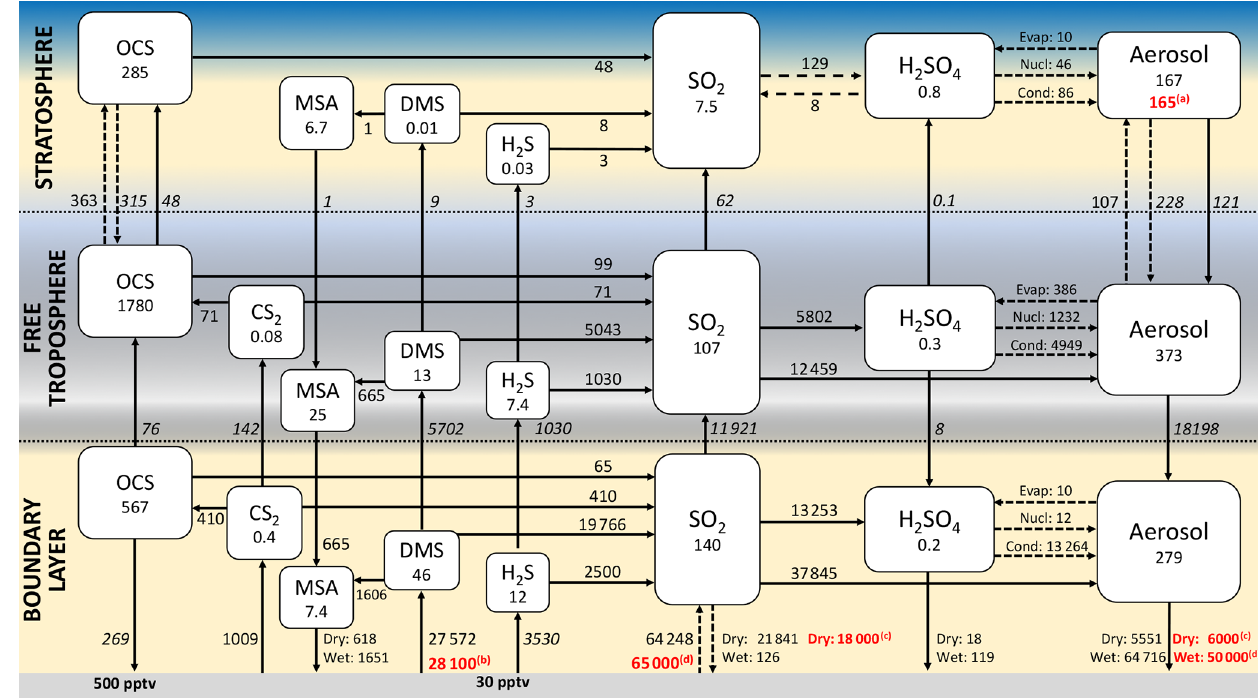
Figure 8. Atmospheric sulfur budget from SOCOL-AERv2 under volcanically quiescent conditions for the year 2000. The figure is produced using output diagnostics that track sulfur fluxes and burdens within the planetary boundary layer (PBL), free troposphere, and stratosphere. Solid arrows show net fluxes and dashed arrows show one-way fluxes, all in gigagrams of sulfur per year (GgSyr − 1 ). Simulated burdens of sulfur species are given within the boxes, in units of gigagrams of sulfur (GgS). Italicized numbers represent fluxes that are derived by balancing other fluxes, assuming steady state of the upper layers. For example, net cross-tropopause fluxes are calculated by balancing the stratospheric chemical fluxes and net cross-PBL fluxes are calculated by balancing the free tropospheric chemical fluxes. Upward OCS and sulfate aerosol cross-tropopause fluxes are calculated based on the residual meridional and vertical air velocities ( v ∗ and w ∗ ) and concentrations at the tropopause. Black numbers: SOCOL-AERv2 results. Red numbers: (a) SAGE-3 λ stratospheric aerosol burden (b) DMS emissions estimated by (Lana et al., 2011) (c) dry deposition fluxes from NCAR-CAM3.5 model (Lamarque et al., 2012) for the year 2000, which participated in ACCMIP (d) multimodel mean wet deposition from ACCMIP models for the year 2000 (Lamarque et al.,